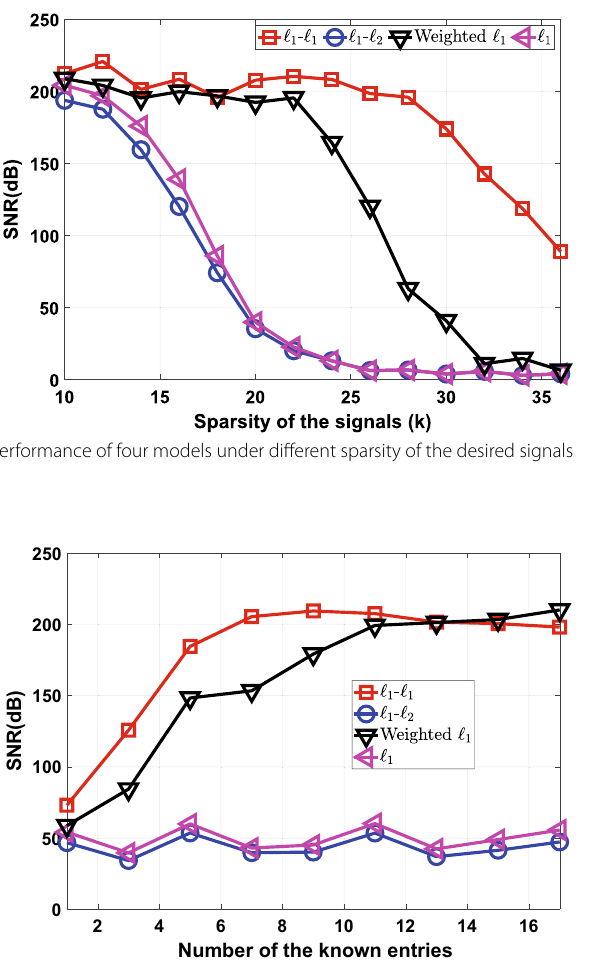
Fig. 5 Recovery performance of four models under different “quality/quantity” of side